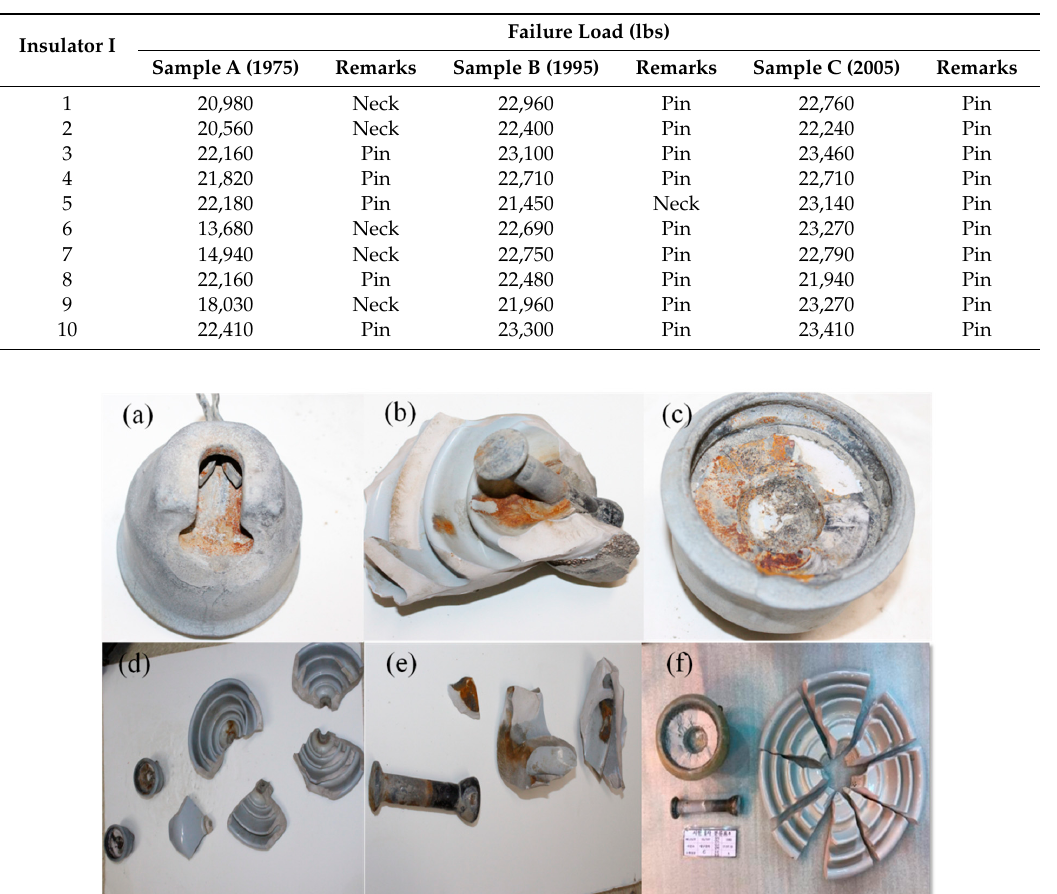
Table 1. Details of mechanical load tests with electrical voltage (M&E) test results.